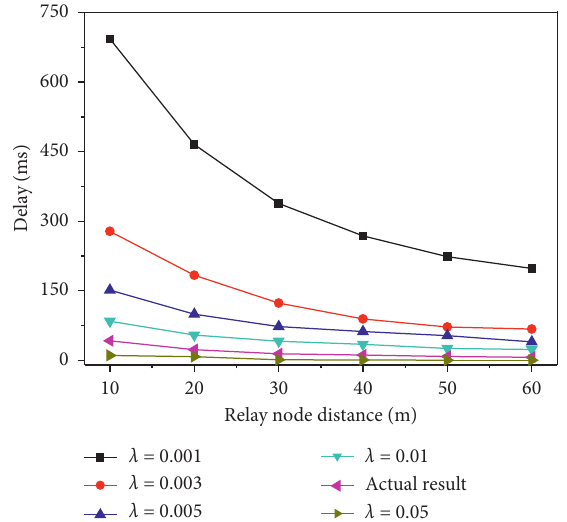
Figure 15: The experimentally measured transmission delay results when p �